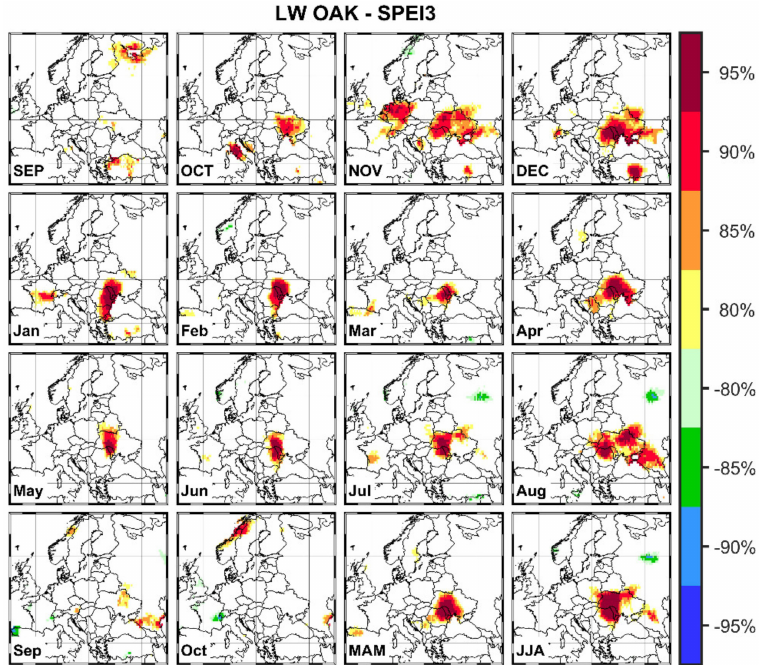
Figure 7. Stability map of the correlation between oak LW and SPEI3 from the previous year September until the current year October. Regions, where the correlation is stable, positive, and significant for at least 80% of windows, are shaded with dark red (95%), red (90%), orange (85%), and yellow (80%). The corresponding regions where the correlation is stable, but negative, are shaded with dark blue (95%), blue (90%), green (85%), and light green (80%).